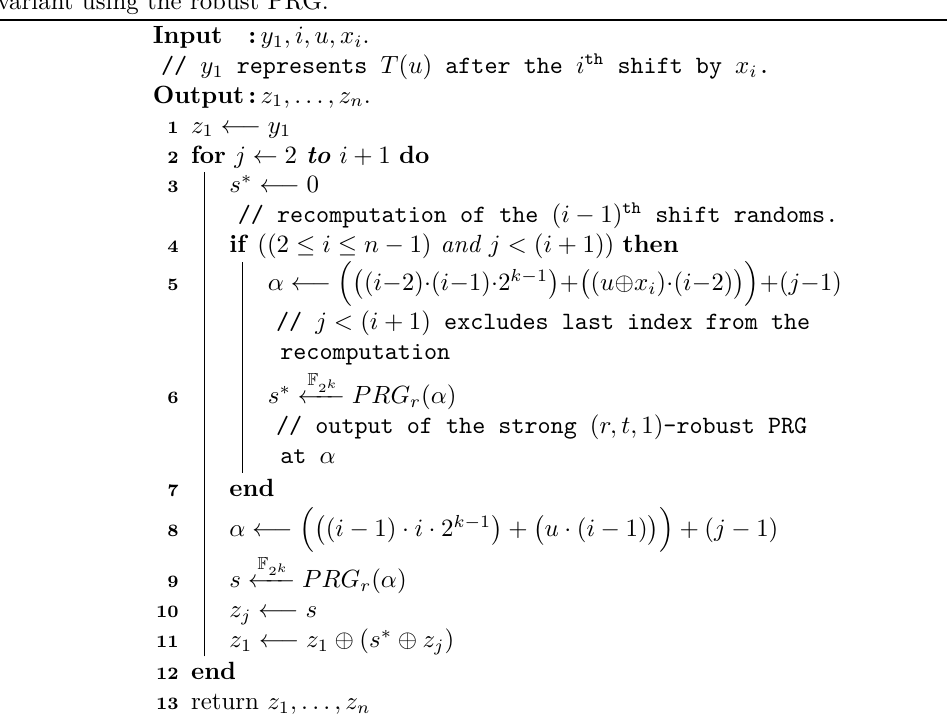
Algorithm 7: LR-i-r : LR procedure for increasing shares variant using the robust